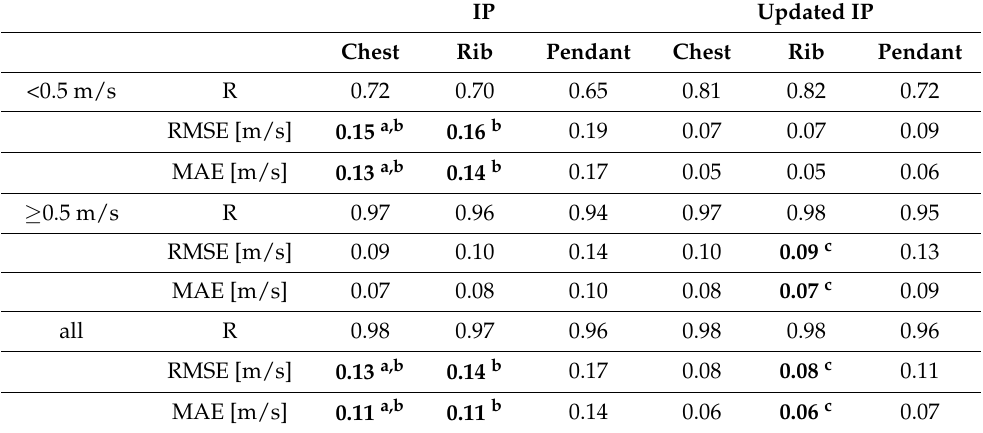
Table 3. Pearson correlation R, MAE, and RMSE for the three locations and two methods, for the subset of data that was available for all three wearing positions. a indicates that the Wilcoxon signed-rank test showed that the underlying absolute errors were lower for this wearing position compared to those for the left lower rib wearing position, with p < 0.01, b indicates that the Wilcoxon signed-rank test showed that the underlying absolute errors were lower for this wearing position compared to those for the pendant wearing position, with p < 0.01, and c indicates that the Wilcoxon signed-rank test showed that the underlying absolute errors were lower for this wearing position when compared to those for the chest wearing position, with p <